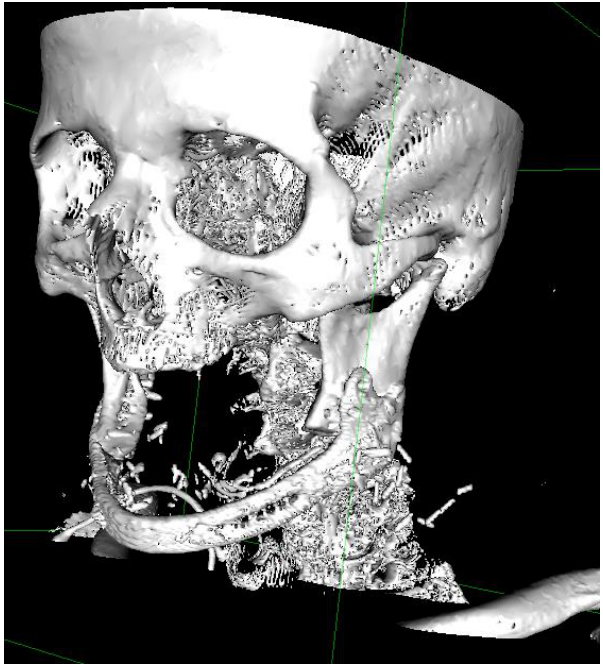
Figure 6. Postoperative CT-scan 3D reconstruction in a patient treated for symphysis BRONJ .